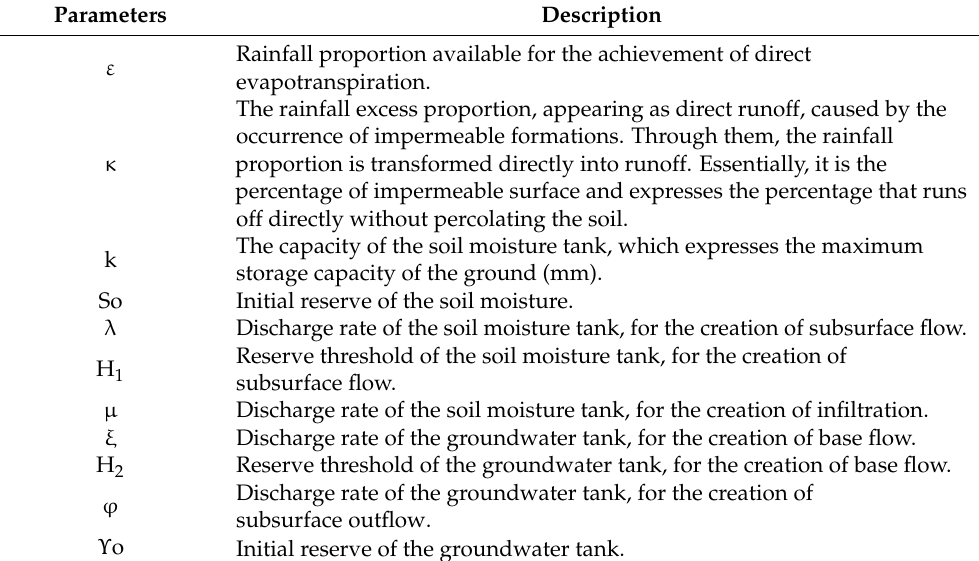
Table 3. Parameters of the manual calibration of the rainfall–runoff model Zygos (Reprinted from Kozanis et al. 2010 [38] and Charizopoulos and Psilovikos [39]).